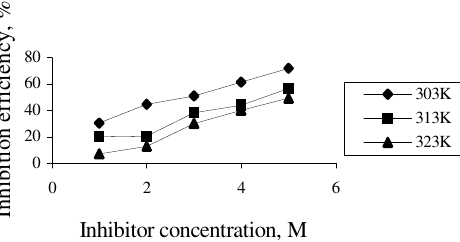
Figure 6. Variation of inhibition efficiency (%) with inhibitor concentrations (M) for mild steel coupons in 2 M HCl solution containing pyridoxolhydrochloride at different temperatures.